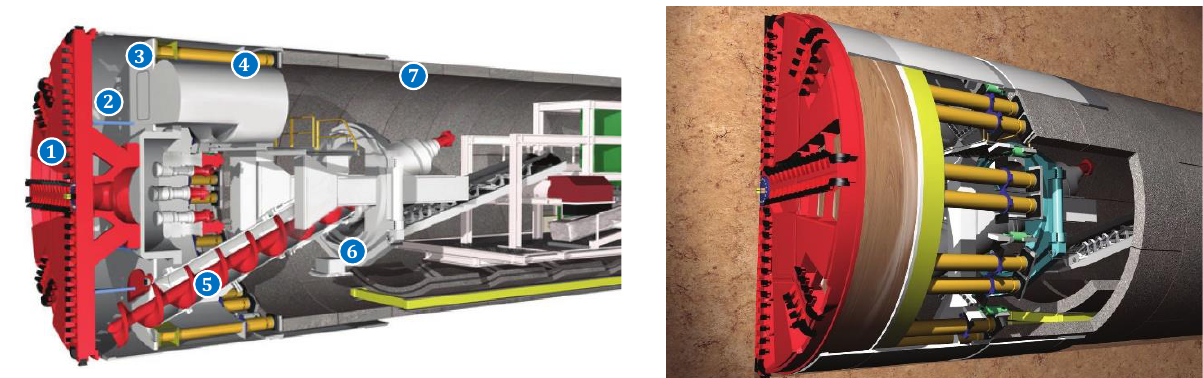
Figure 2. Overview of EPB